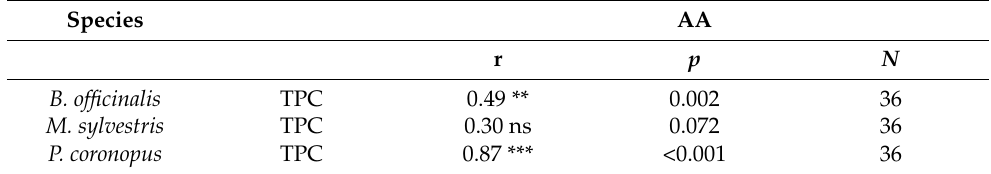
Table 5. Pearson’s correlation between total phenolic content (TPC) and antioxidant activity (AA) in leaves of Borago officinalis , Malva sylvestris and Plantago coronopus hydroponically grown under greenhouse in winter or in spring and subjected to three consecutive cuts and analyzed fresh or boiled. Each analysis was performed in triplicate. Species AA r p N B. officinalis TPC 0.49 ** 0.002 M. sylvestris TPC 0.30 ns P. coronopus TPC 0.87 ***